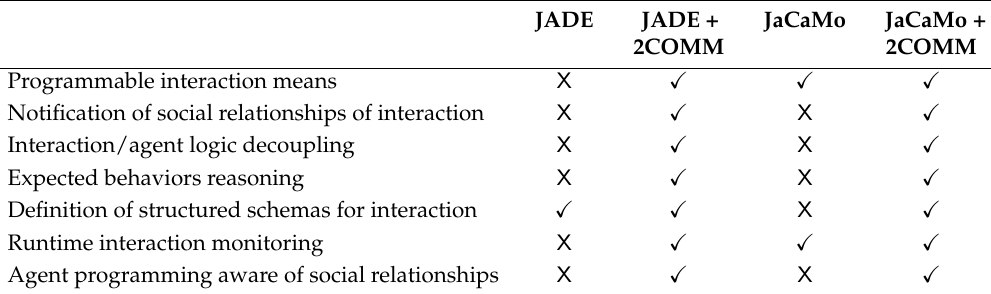
Table 1. Comparison among JADE, JaCaMo, and improvements provided by an explicit representation of social